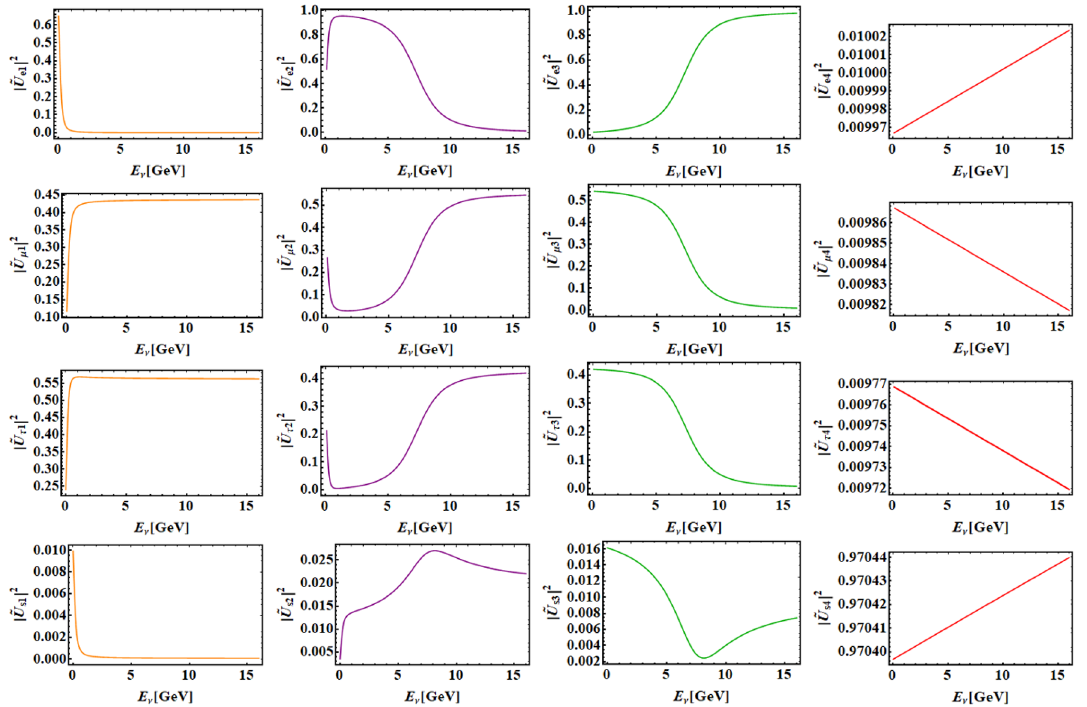
Figure 3 . Shown are the plots of matter-e(cid:11)ected mixing matrix elements’ modulus squares with respect to the neutrino energy E (cid:23)